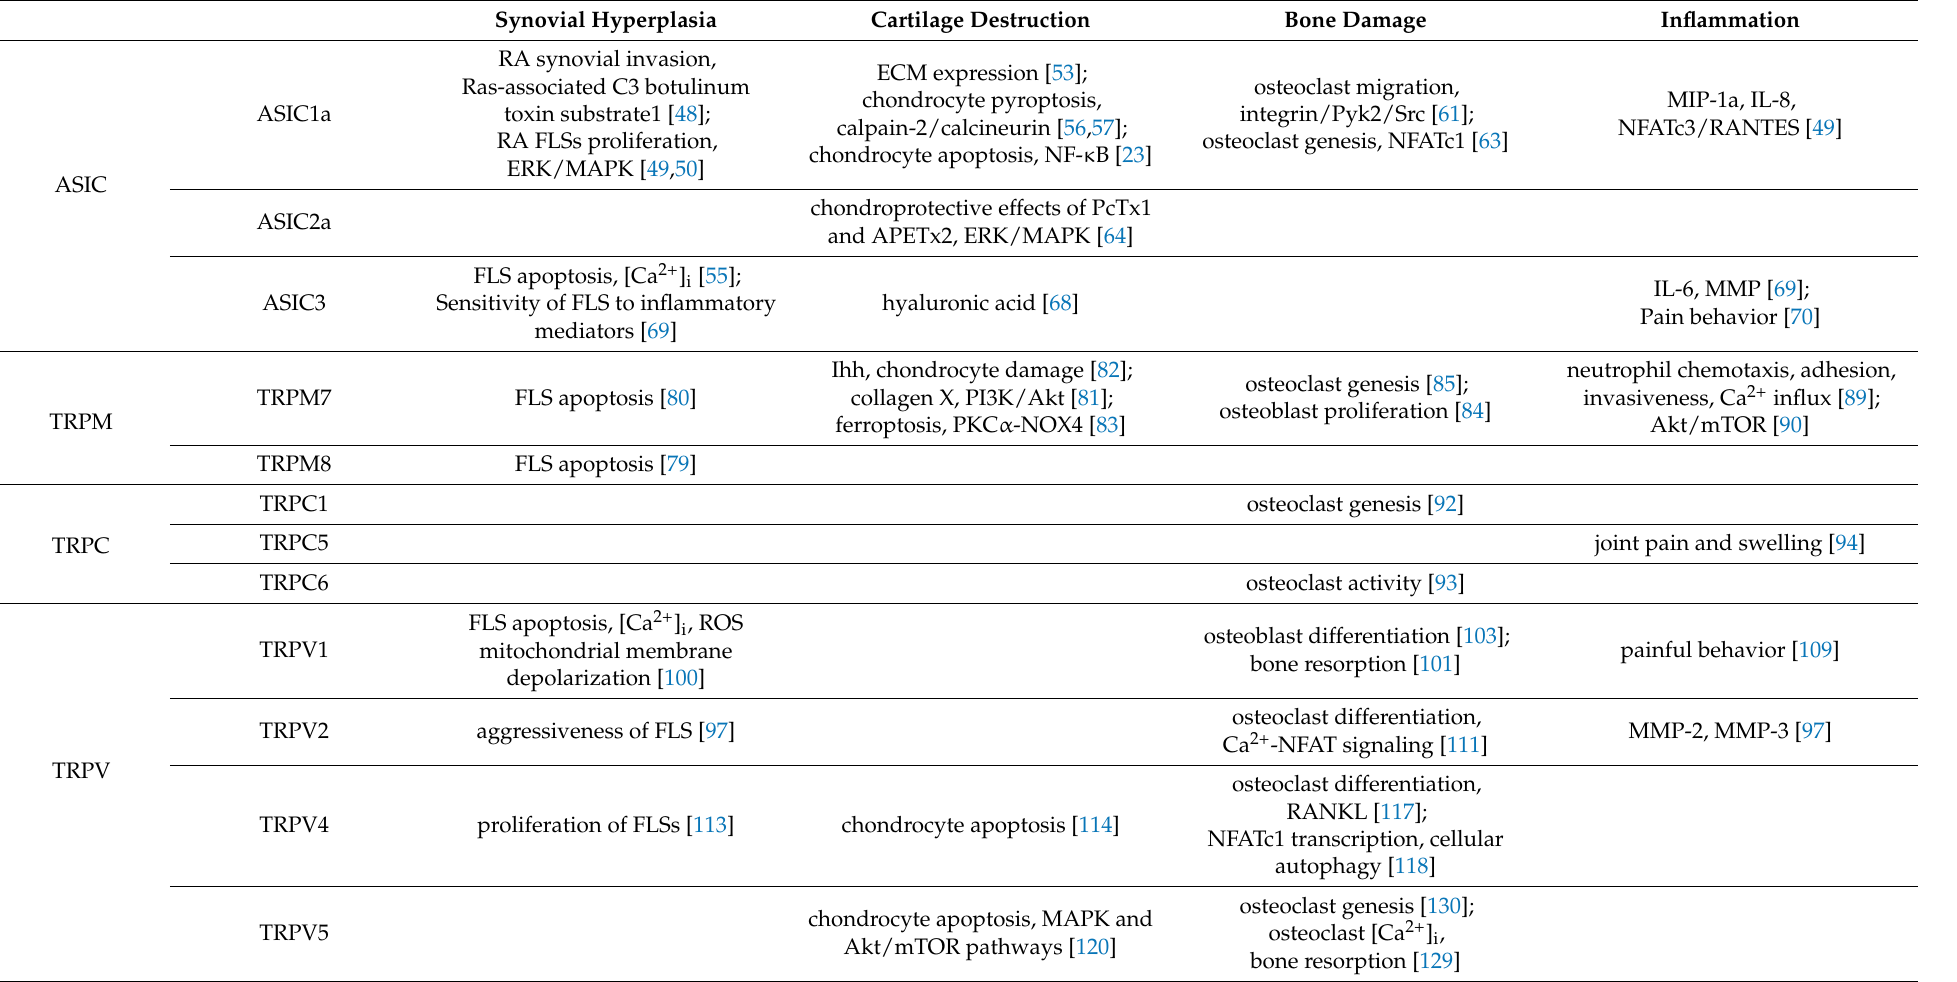
Table 1. Role of activating the calcium-permeable channel in